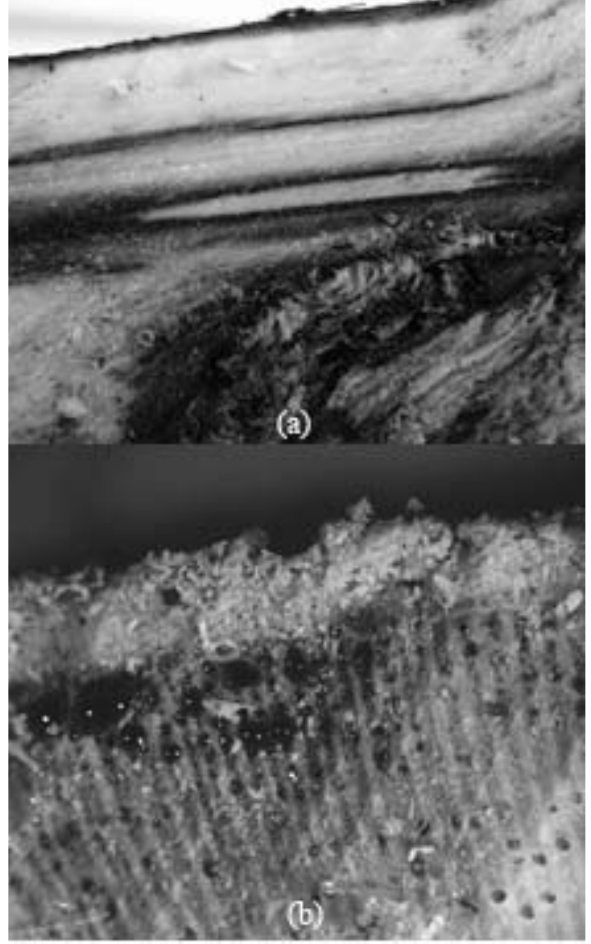
Fig. 4. (a) Dark wood streaking and white rot on longitu- dinal section of grapevine trunk. (b) Brown-black spots in cross sectioned